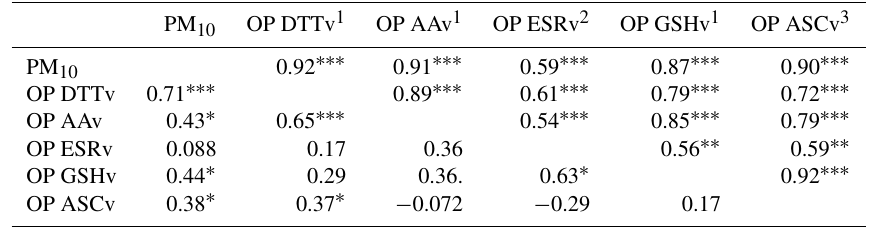
Table 3. Spearman correlation of the OPv in the cold (upper part) and the warm period (lower